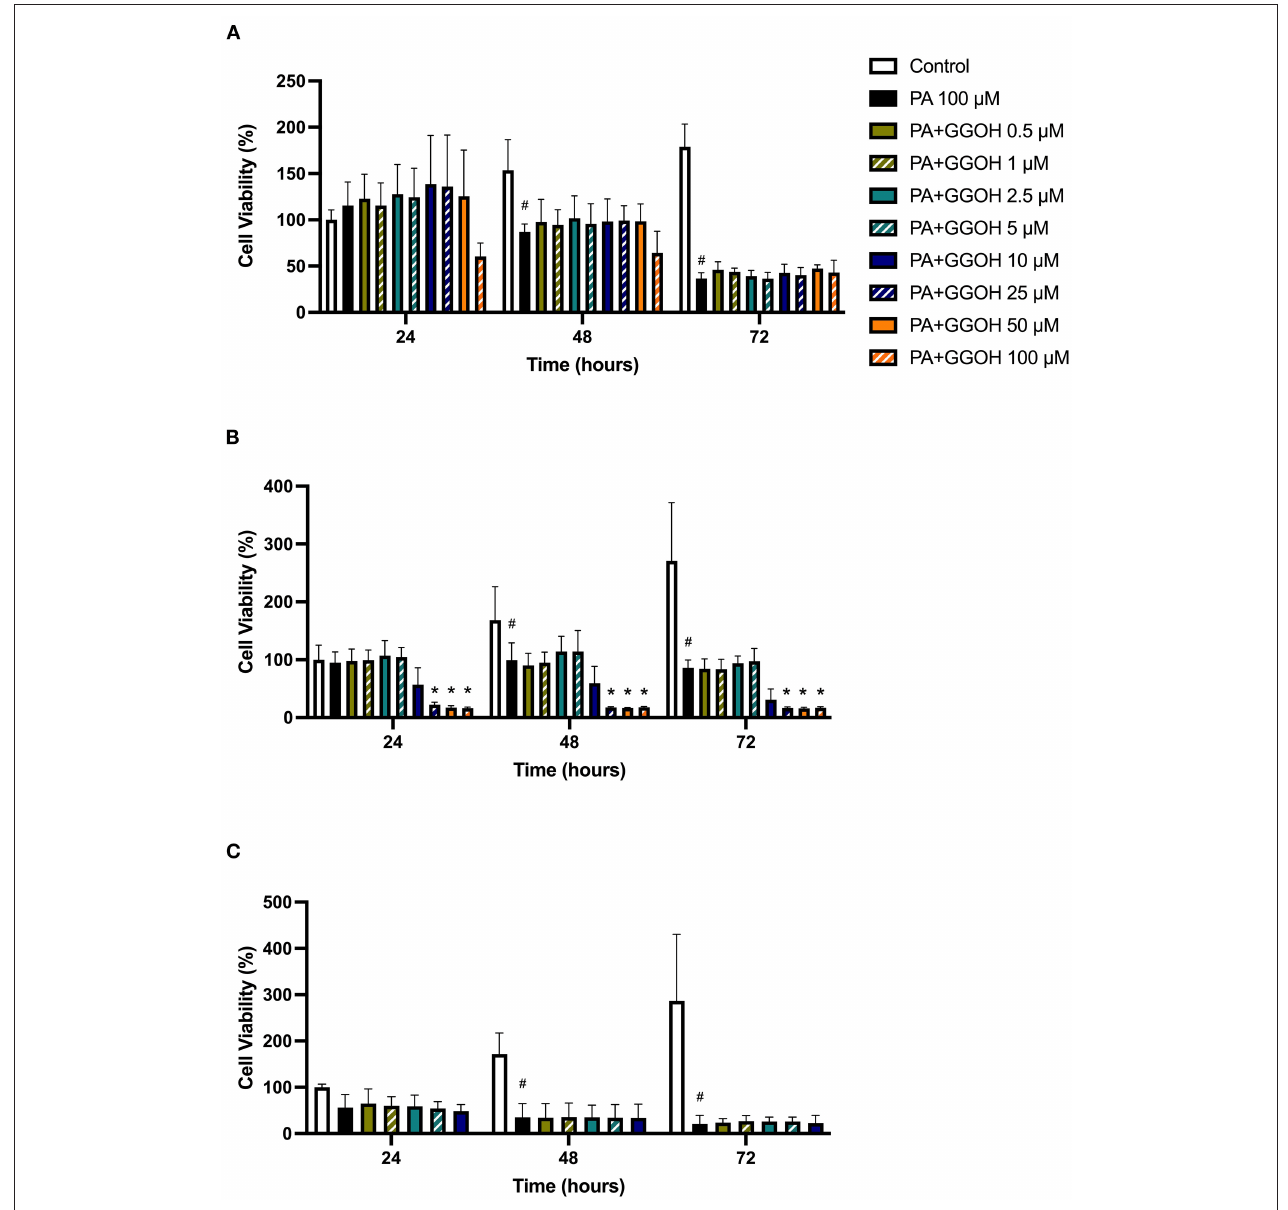
FIGURE 6 | (A) NOF (B) OKF6/TERT-2 (C) NOK viability in the presence of different GGOH concentrations in combination with PA for 72h. All (A,B) N = 3 except Control, PA, and PA+GGOH 10 µ M of (B) N = 4, all conditions of (C) N = 2. Mean + / − standard deviation (SD). # shows statistical significance (p < 0.05) in comparison to untreated control and * shows statistical significance (p < 0.05) between 100 µ M PA group and test